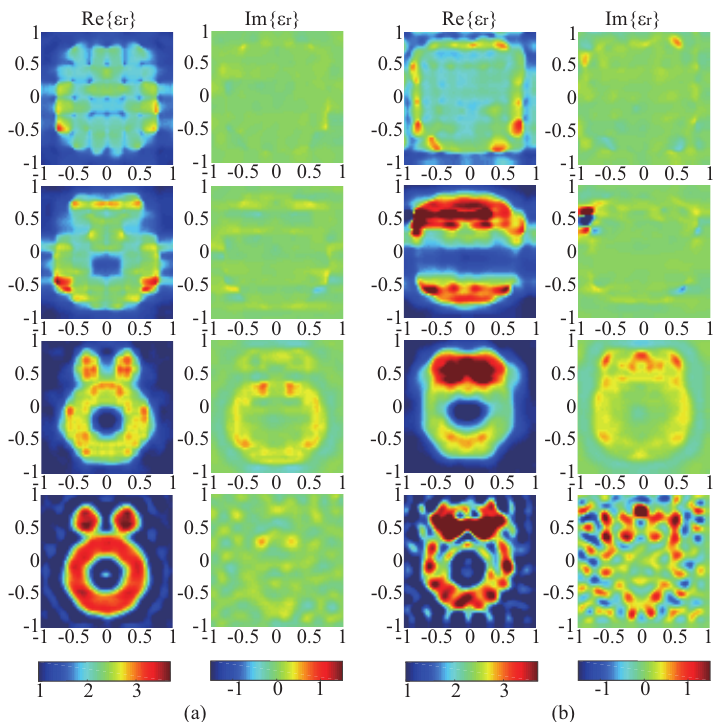
Figure 4. Reconstructed results by WT-TSOM with ( a ) the bior3.5 wavelet bases and ( b ) the db20 wavelet bases for “Austria” profile with ε r = 3.5. The 1st, 2nd , 3rd, and 4th rows correspond to the reconstructed results of the first, second, third, and fourth rounds of optimization, respectively. The 1st, 2nd, 3rd, and 4th rounds of optimization correspond to β being 6, 3, 0.5, and 0, coupled with M w being 64, 128, 256, and 1024, respectively.